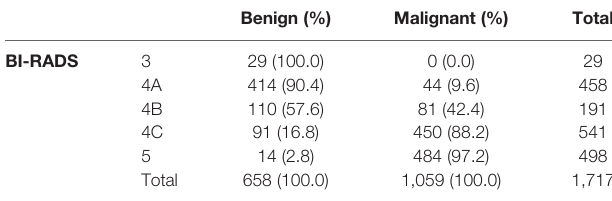
TABLE 2 | Basic BI-RADS classi fi cation information of